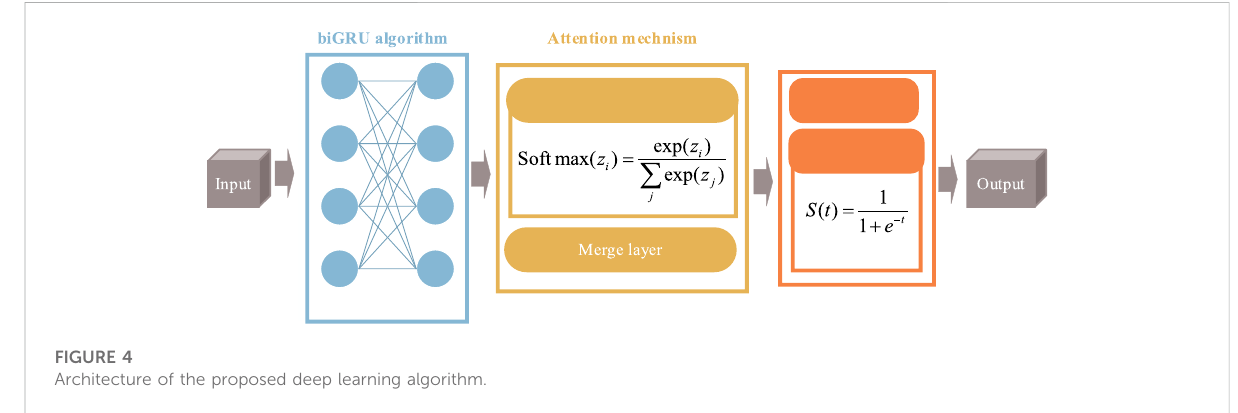
α k (cid:2) 1. ρ represents the learning rate of the parameters with (cid:5) k ADMM algorithm. λ represents a weight parameter that balances the trade-off between the two terms in the objective function. θ represents a non-negative integer.